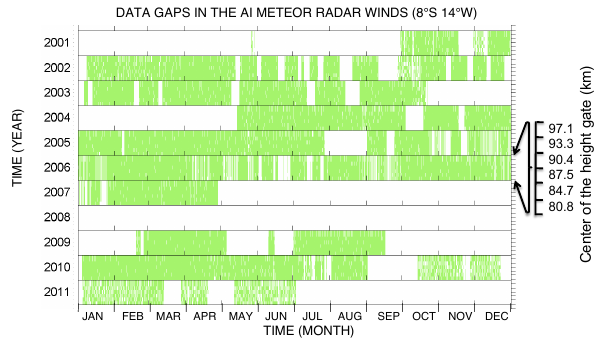
Fig. 1. A schematic showing the available data from the radar on Fig.1. AschematicshowingtheavailabledatafromtheradaronAscensionIslandfrom2001– Ascension Island from 2001 to 2011. tary waves. From the figure it can be seen that there are a number of low-frequency oscillations evident in both the radar zonal and meridional wind observations. At lower frequencies the wind time series become dominated by the signatures of the MSAO and the AO. It is notable that in these long-term time-series the largest amplitude component in the zonal winds is the MSAO.The modulation of the amplitude of the SAO appears as a broadening of the semiannual peak, as can be seen in the zonal wind spectra shown in Fig.2. This can be shown by analysing the side-lobe